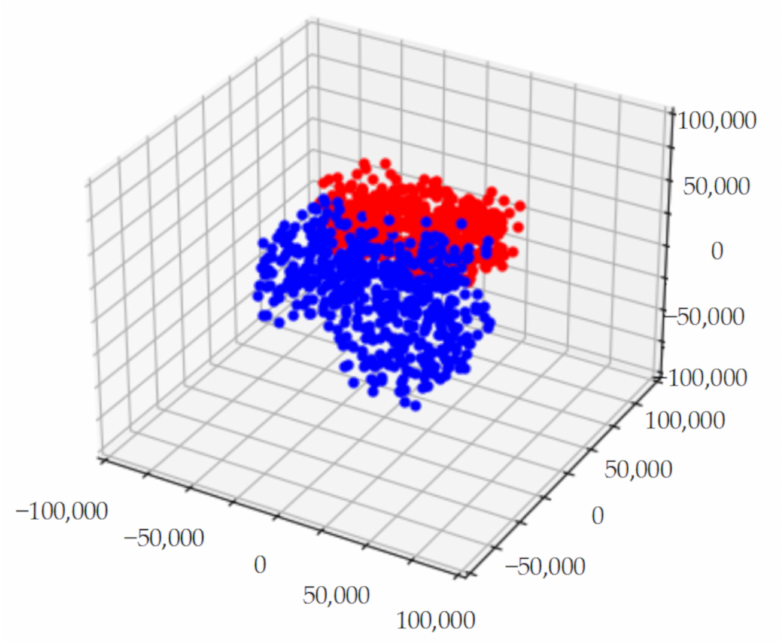
Figure 13. Start and end point set of random cross sector motion (red as the starting point and blue as the ending